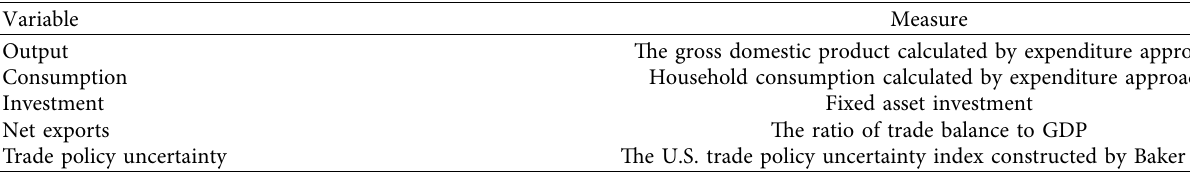
Table 1: Description of the variables.